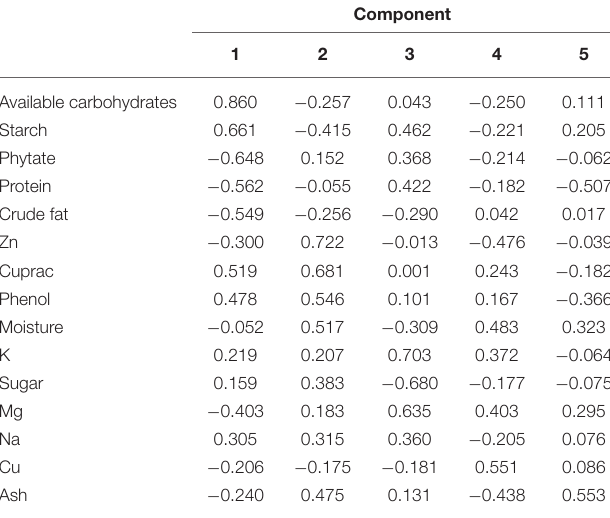
TABLE 5 | KMO and Bartlett’s Test to test partial correlation and unrelated variables. Kaiser-Meyer-Olkin Measure of Sampling Adequacy.